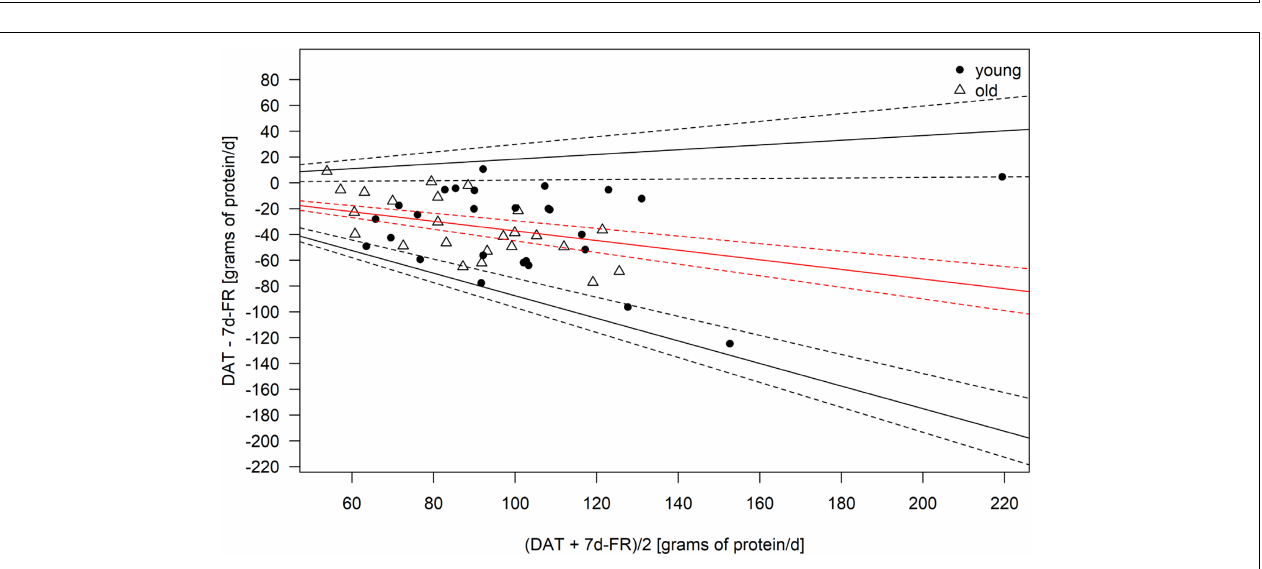
FIGURE 3 | Bland–Altman Plot of the protein intake as calculated from the 7 d-FR and the visually aided DAT. Legend: Red solid line, mean; black solid lines, 95% limits of agreement; dotted lines, 95% of the respective solid